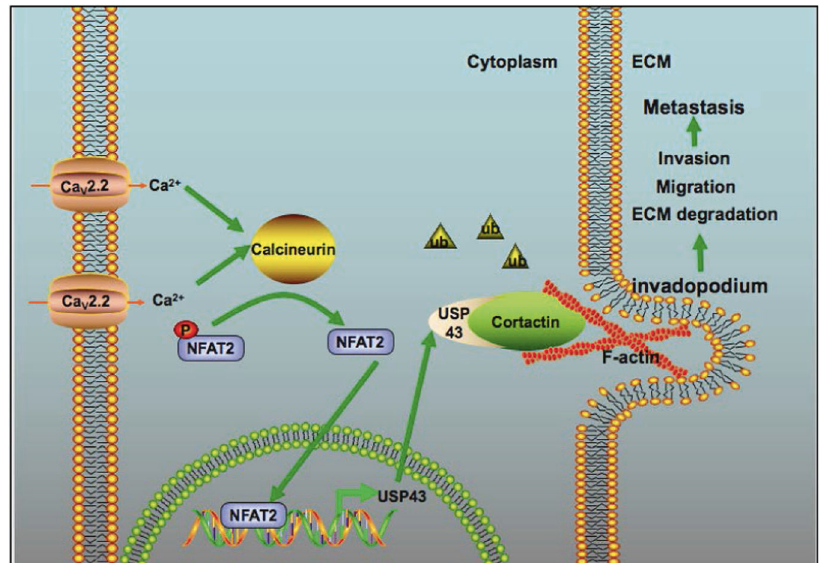
Fig. 9 The working model of deubiquitinase USP43 mediating the functions of the calcium channel Cav2.2 in cortactin stabilization, invadopodia formation, and metastasis. Ca v 2.2 up-regulates USP43 expression through NFAT2 dephosphorylation and nuclear localization. USP43 stablizes cortactin through deubiquitination and promotes invadopodia formation and